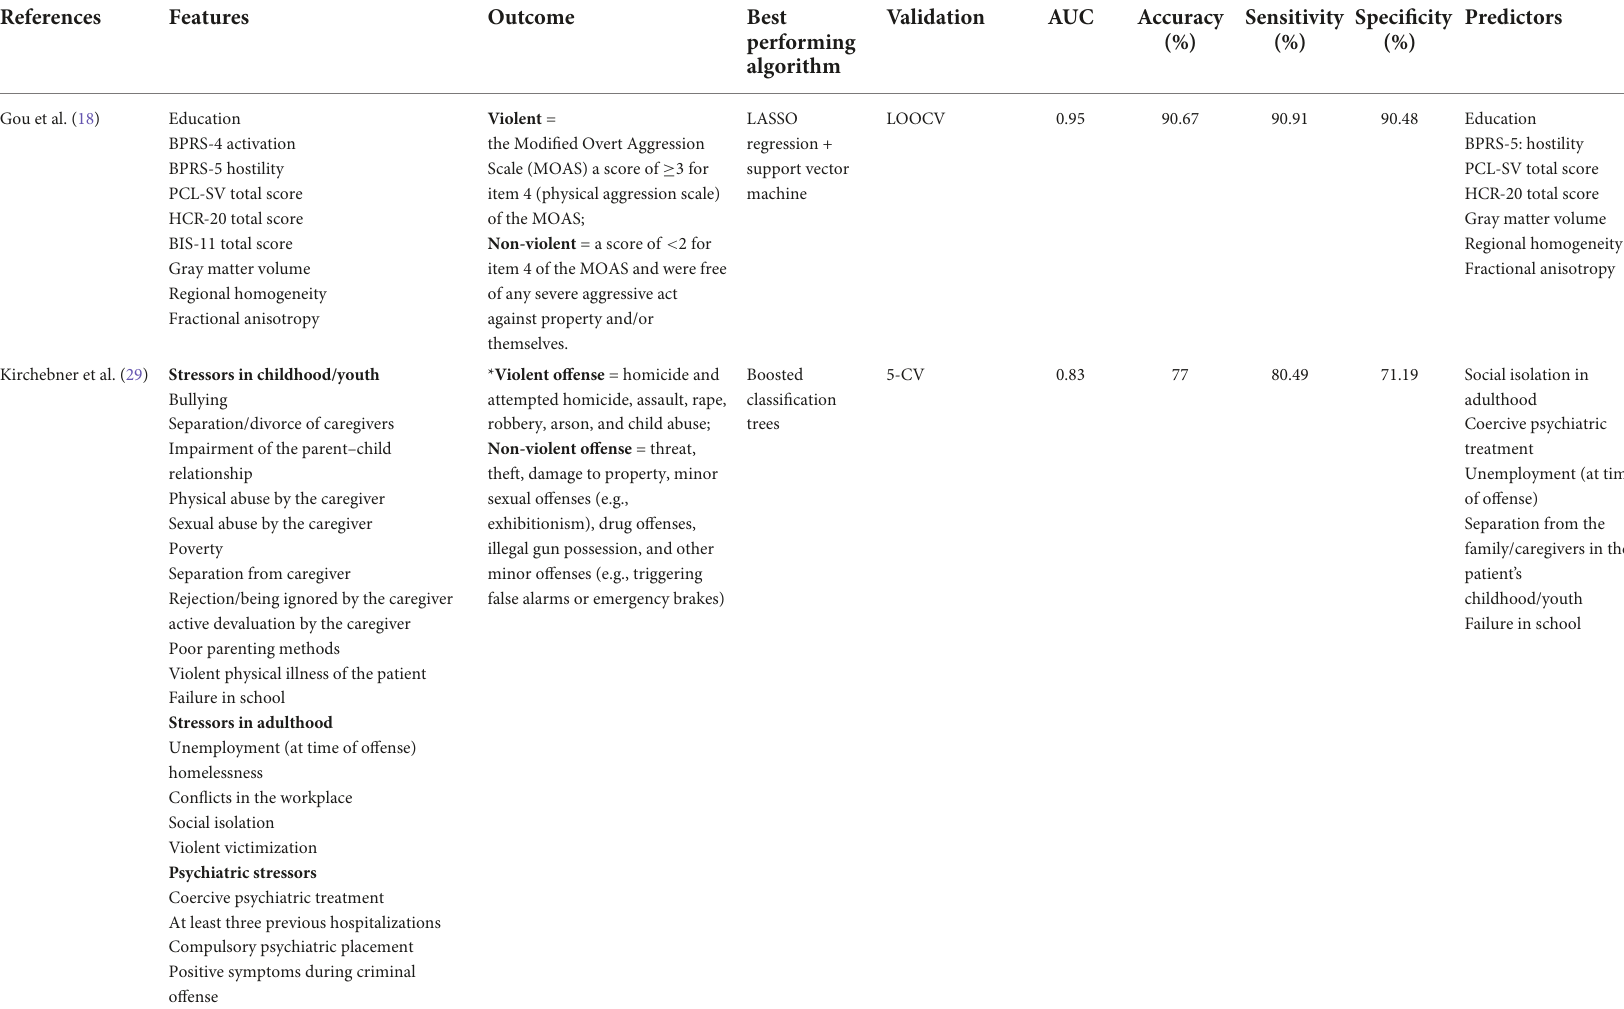
TABLE 2 Features and predictors of the ML